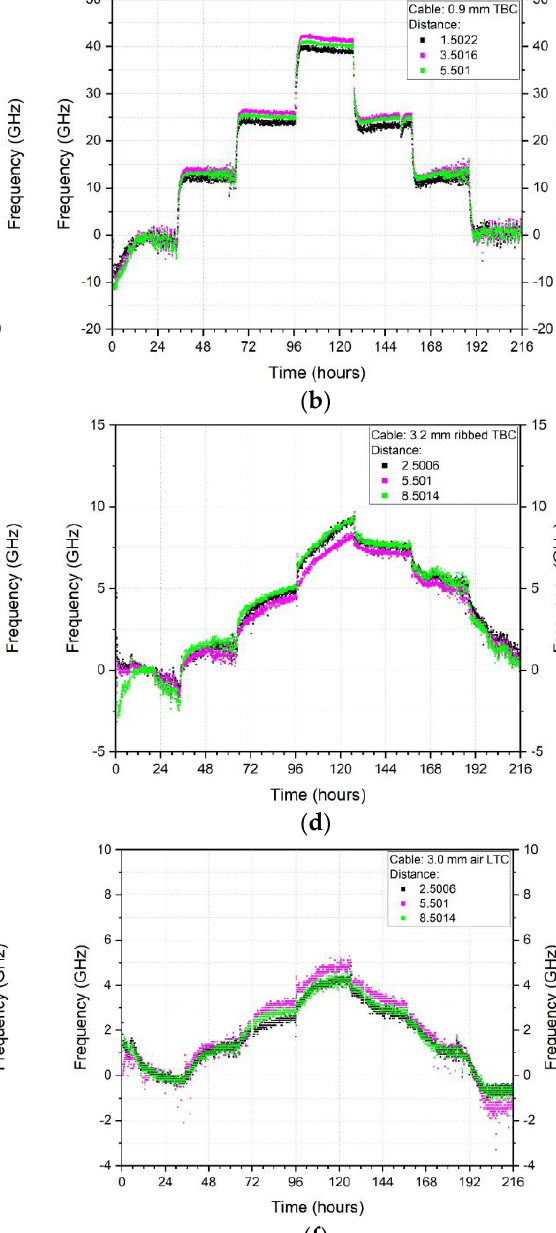
Figure A2. Time-Frequency plots for the time stability analysis during humidity steps of 30 – 90 – 30 – 20% rel. H. ( a ) bare fibre cable ( b ) 900 μ m tight buffered cable ( c ) 2.0 mm black tight buffered cable ( d ) 3.2 mm blue ribbed tight buffered cable ( e ) 3.8 mm gel filled loose tube cable and ( f ) 3.0 mm air filled loose tube cable.